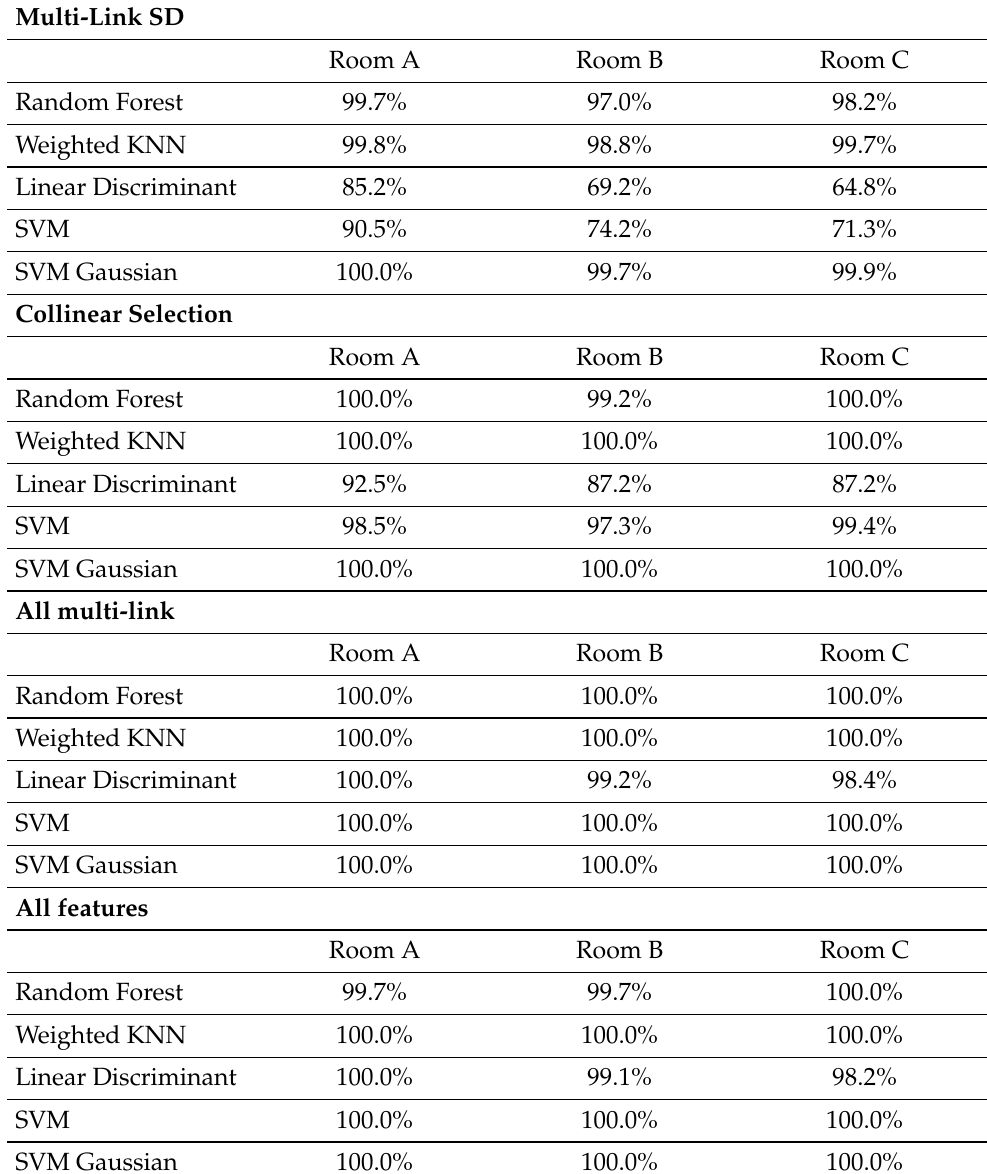
Table 10. Accuracy rates for multi-link approach in all